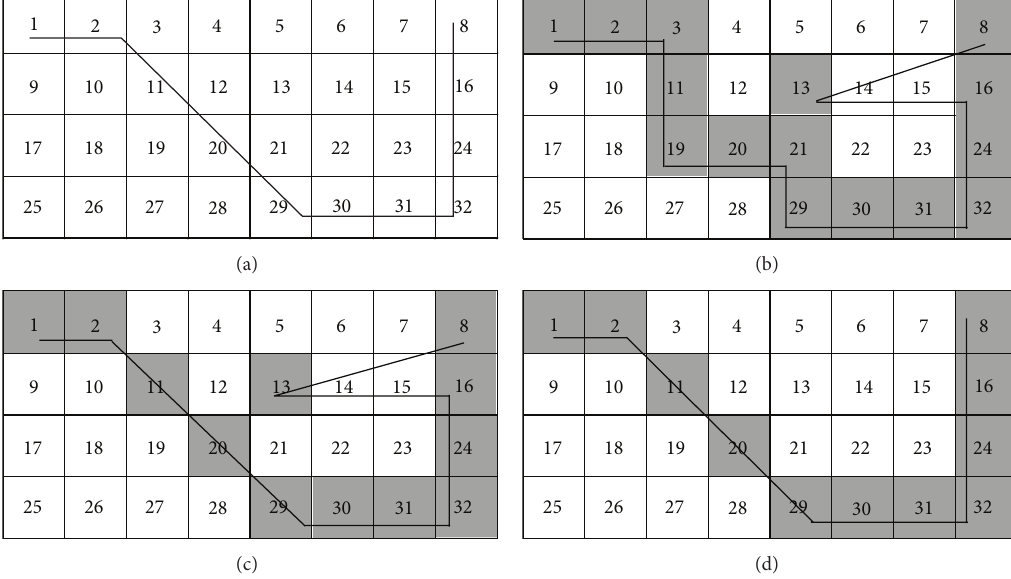
Figure 7: Experimental results of the overall tracking system: (a) path actually performed; (b) raw readings detected by antennas; (c) partially processed path; (d) final result of the raw readings processing.